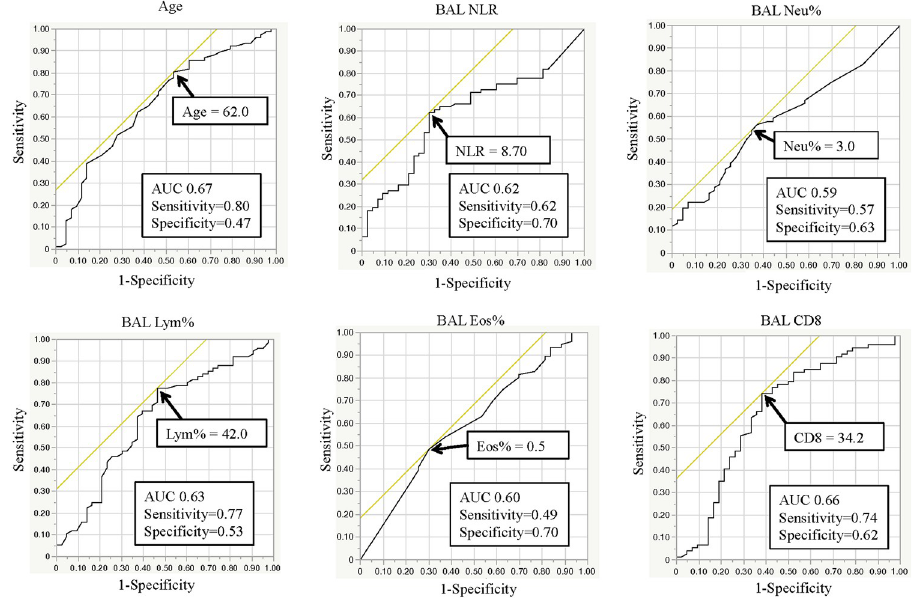
Fig 2. ROC curve analysis to establish cut-off values for PF-ILD diagnostic predictors. Abbreviations: NLR: neutrophil-to-lymphocyte ratio; AUC: area under the ROC curve; ROC: receiver operating characteristic.